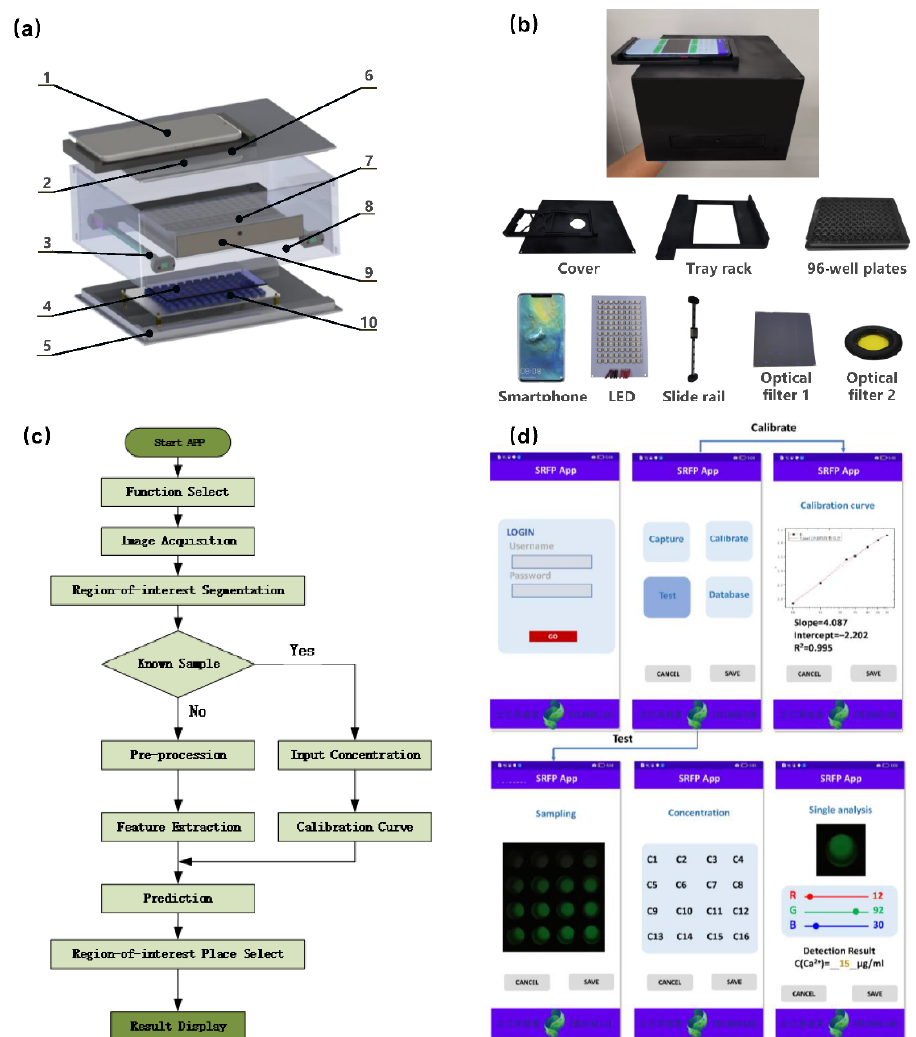
Figure 2. Schematic illustration of homemade SRFP platform and the self-made SRFP-App. ( a ) Details design of the SRFP platform are displayed. ( b ) Fluorescence responses were obtained from red, green, and blue channels at the same fluorescence intensity and exposure time. ( c ) Diagram showing the operation processing steps of the self-made SRFP-App. ( d ) Detailed operations of the SRFP-App software interface.